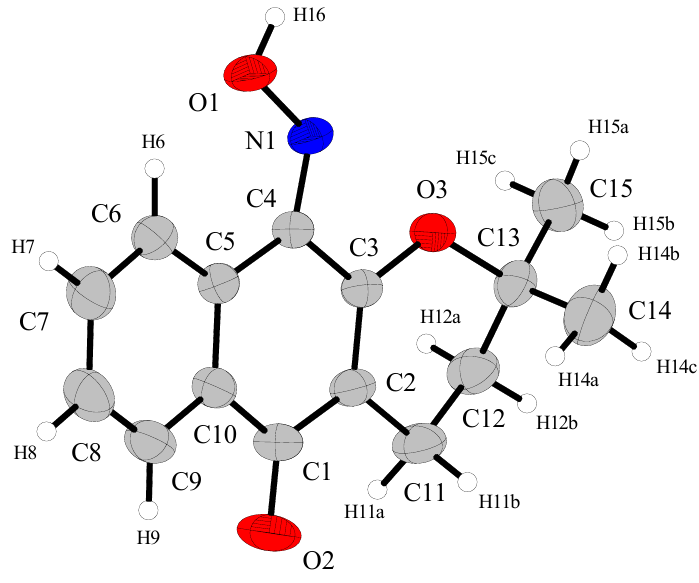
Figure 2. View of the ORTEP projection for ( 1 ) with respective atom-numbering scheme [19]. Displacement ellipsoids are draw at the 50% probability level.